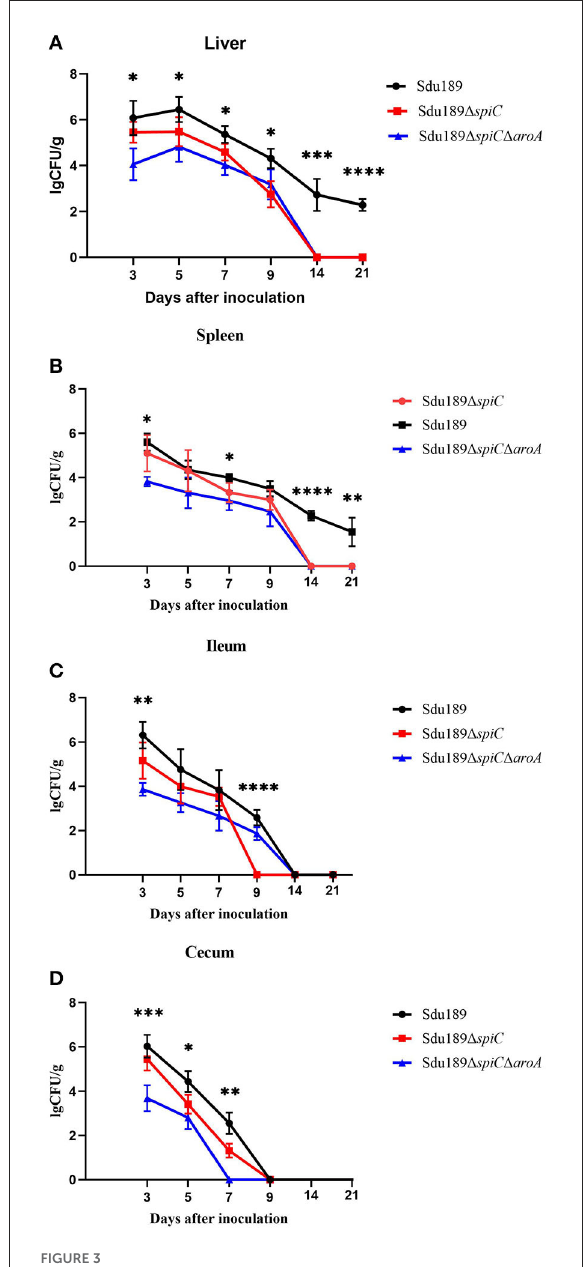
FIGURE3 Bacterial colonization in tissues and organs of immunized mice. Mice were immunized with parental strain Sdu189, vaccine candidates Sdu189 1 spiC and Sdu189 1 spiC 1 aroA . Bacterial colonization in the liver (A) , spleen (B) , ileum (C) , and cecum (D) of the immunized mice. * p < 0.05, ** p < 0.01, *** p < 0.001, and **** p < 0.0001 compared with the bacterial colonization number of control group mice by one-way ANOVA followed by Bonferroni’s multiple comparison test. Data are presented as mean ± SEM of log10 CFU/g.